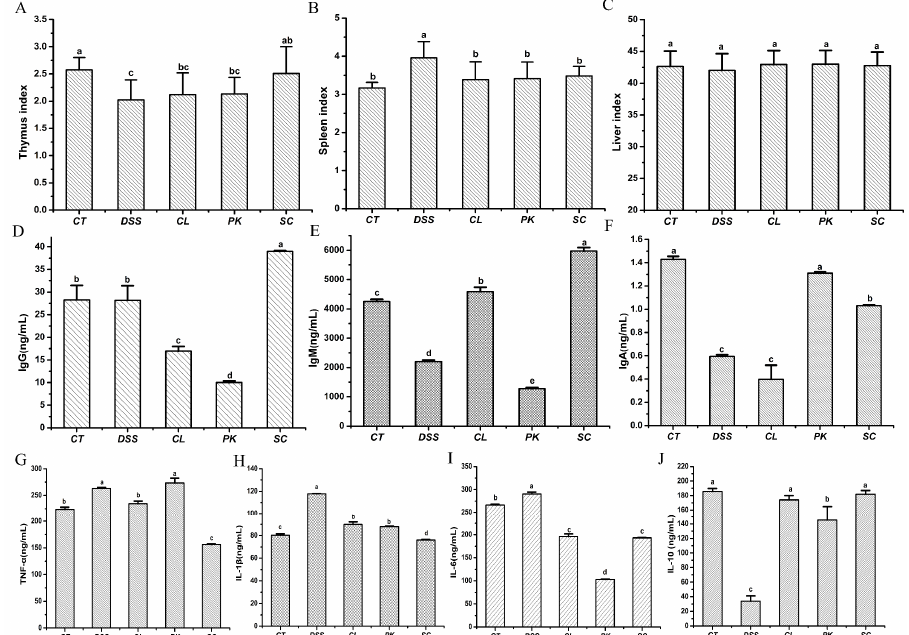
Figure 3. Organ index, contents of immunoglobulin and inflammatory factors in serum of Balb/c mice. ( A − C ) Thymus index, Spleen index, Liver index; ( D − F ) IgG, IgM, IgA; ( G − J ) TNF −α , IL − 1 β , IL − 6, IL − 10. Different lowercase letters marked on the column represent significant difference ( p < 0.05). Four inflammatory factors and three immunoglobulin in serum of the Balb/c mice were determined by ELISA kit in order to detect the effects of the three yeast strains on inflammatory mediators (Figure 3D − G). The pro-inflammatory cytokines expression of the Balb/c mice in the model group after drinking DSS water, including TNF −α , IL − 6 and IL − 1 β , increased significantly compared with those in the blank group ( p < 0.05), but the contents of anti-inflammatory factors IL − 10 and immunoglobulin declined ( p < 0.05). After oral administration of the three yeast strains, especially the S. cerevisiae I4, TNF −α , IL − 6 and IL − 1 β decreased to varying degrees ( p < 0.05), while IL − 10, IgM, IgA and IgG in- creased ( p < 0.05). The results indicated that oral administration of yeasts alleviated colitis in the Balb/c mice by reducing pro − inflammatory cytokines and increasing anti − inflam- matory factors and regulating immune status. 3.6. Regulation of Intestinal Microflora of the Mice with Colitis by Yeasts Intestinal gut microbiota disorder is a key factor leading to inflammatory bowel dis- ease (IBD), mainly by inducing abnormal immune response of intestinal mucosa [43]. The Shannon, Chao1 and ACE index are used to reflect the diversity and richness of commu- nities. It can be seen from Figure 4A that the Shannon index of the model group was re- duced compared with the control group ( p < 0.05), indicating that the diversity of intestinal gut microbiota in mice was decreased. However, the value increased after intragastric ad- ministration of S. cerevisiae I4 although there was no significant difference. In addition, for